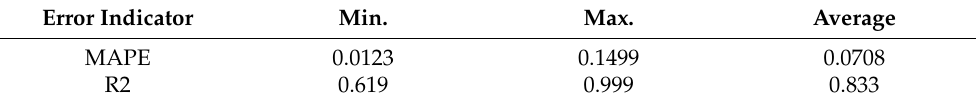
Table 6. MAPE and R2 statistics of residual strength and residual life forecasting results.